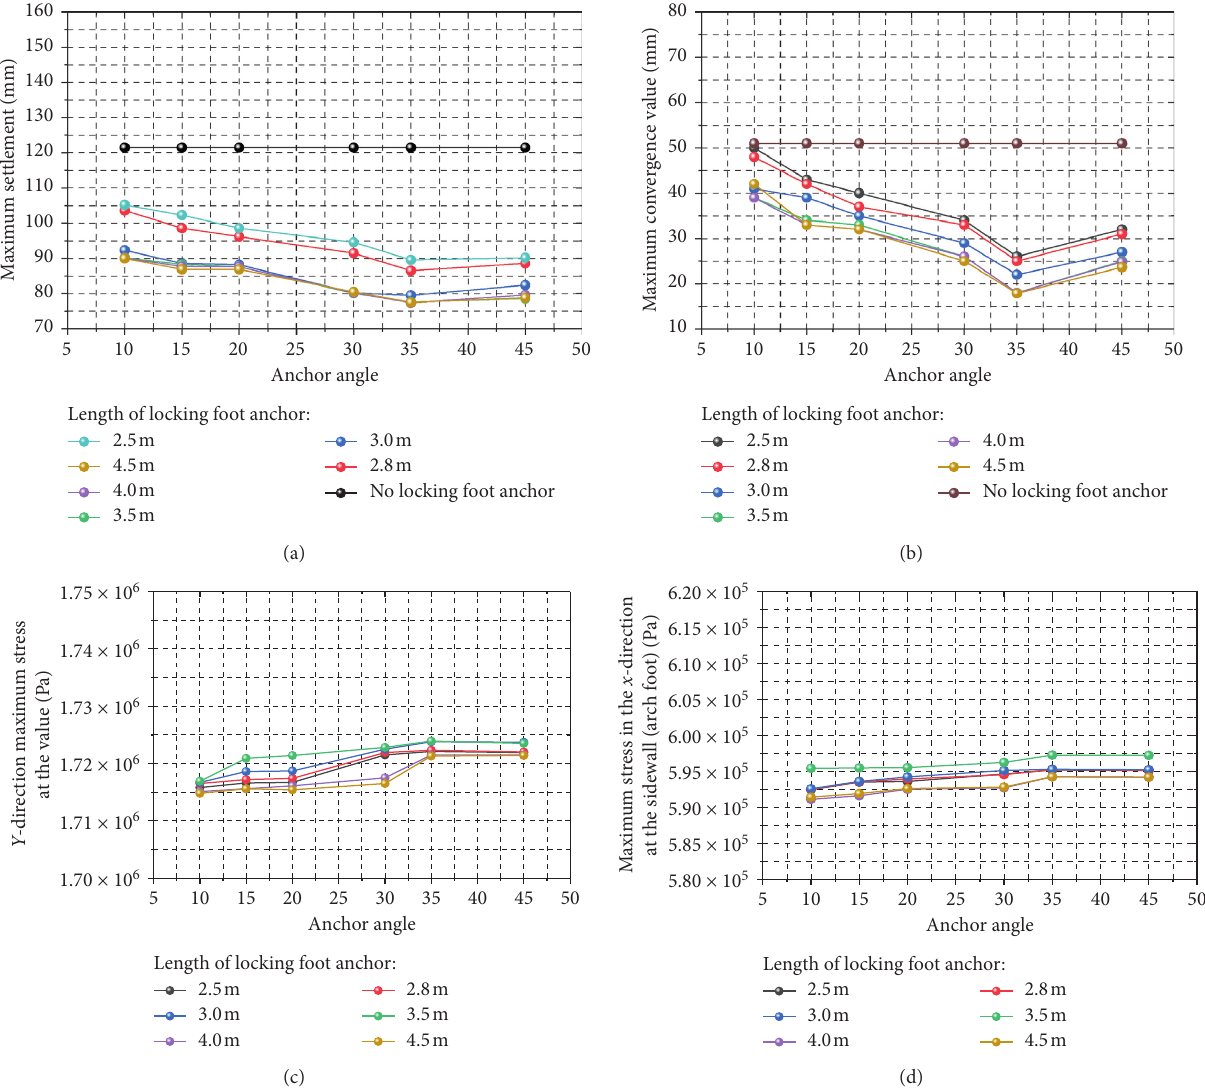
Figure 16: Simulation result graphs: (a) the maximum settlement for different anchor pipe lengths; (b) the maximum convergence for different anchor pipe lengths; (c) the maximum pressure at the vault for different anchor pipe lengths; (d) the maximum stress in the x -direction for different anchor pipe